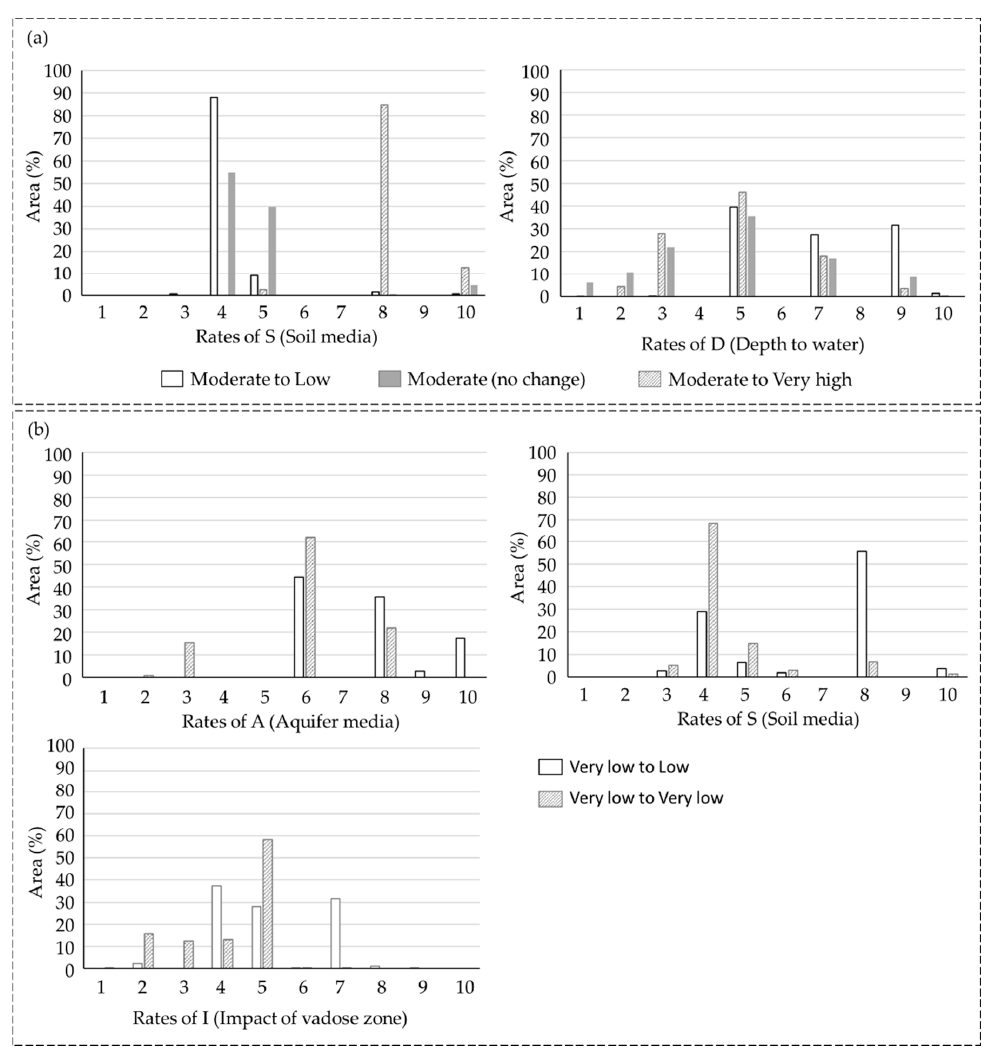
Figure 6. Distribution of rates of the different parameters within the area where significant changes are observed from ( a ) “Moderate” or from ( b ) “Very low” classes in the original DRASTIC to other vulnerability classes in O-DRASTIC.